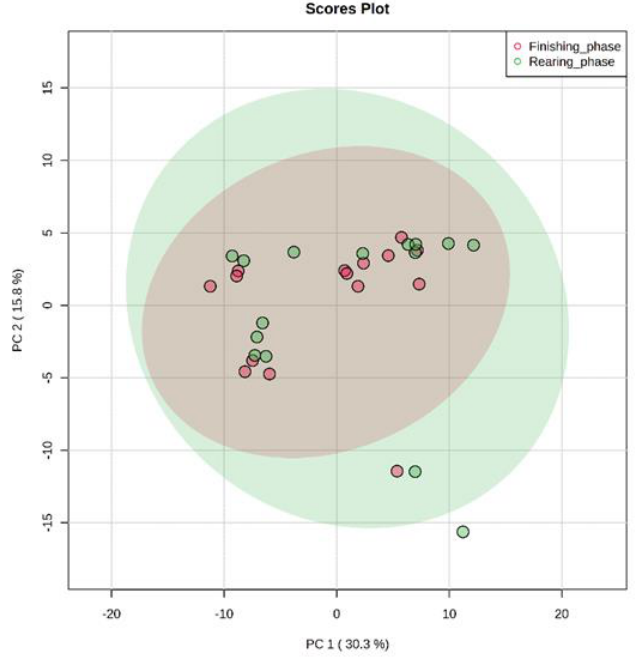
Figure 3. Principal component analysis (PCA) scores plot of metabolome distribution of bulls’ blood plasma between the different production stages (finishing phase and rearing phase).